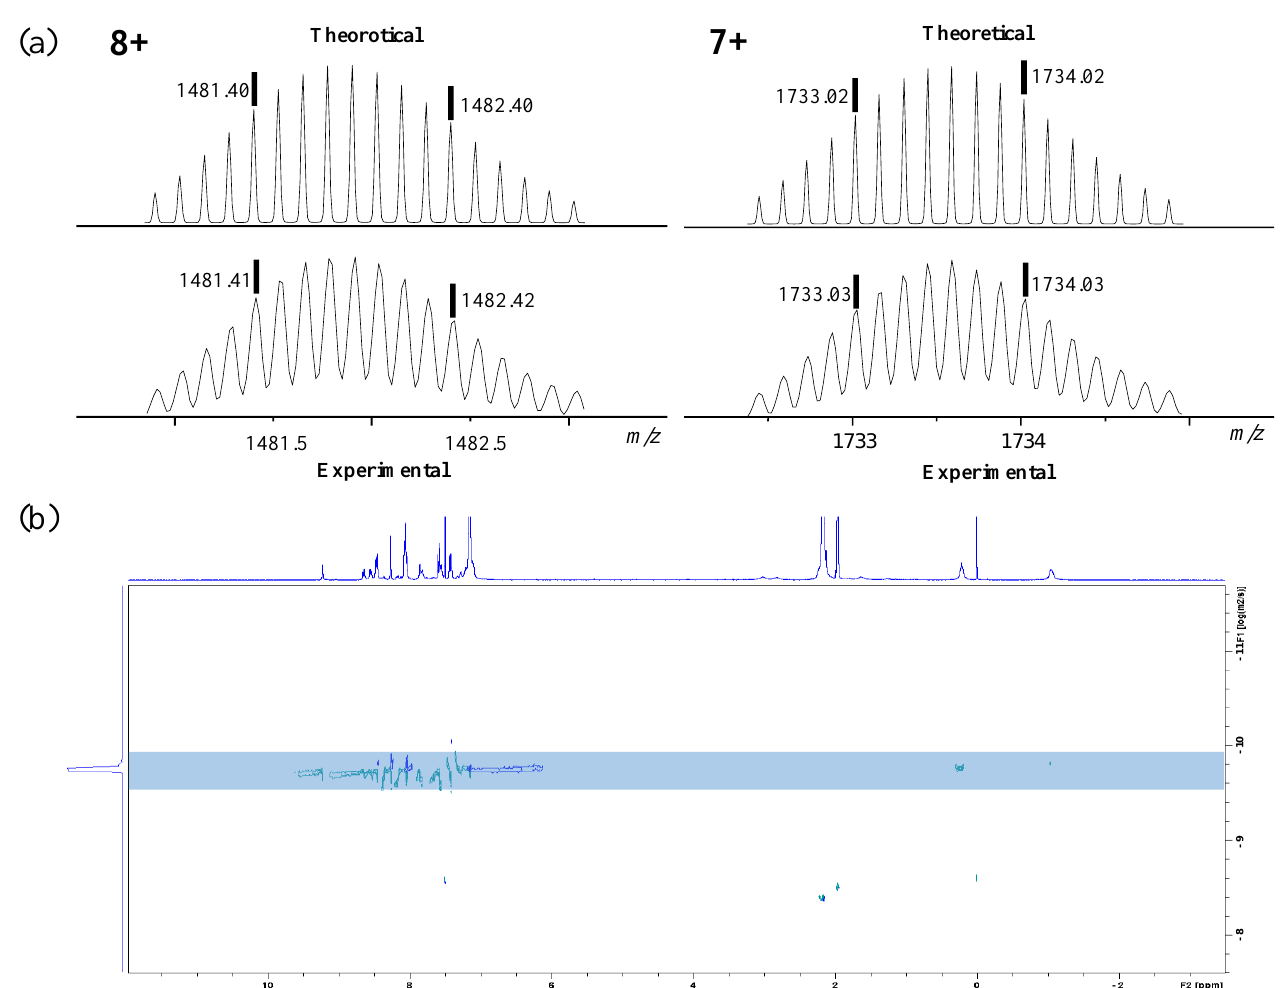
Figure 2. ( a ) ESI-MS spectra of Cage-1 ; ( b ) 2D DOSY spectrum of Cage-1 .